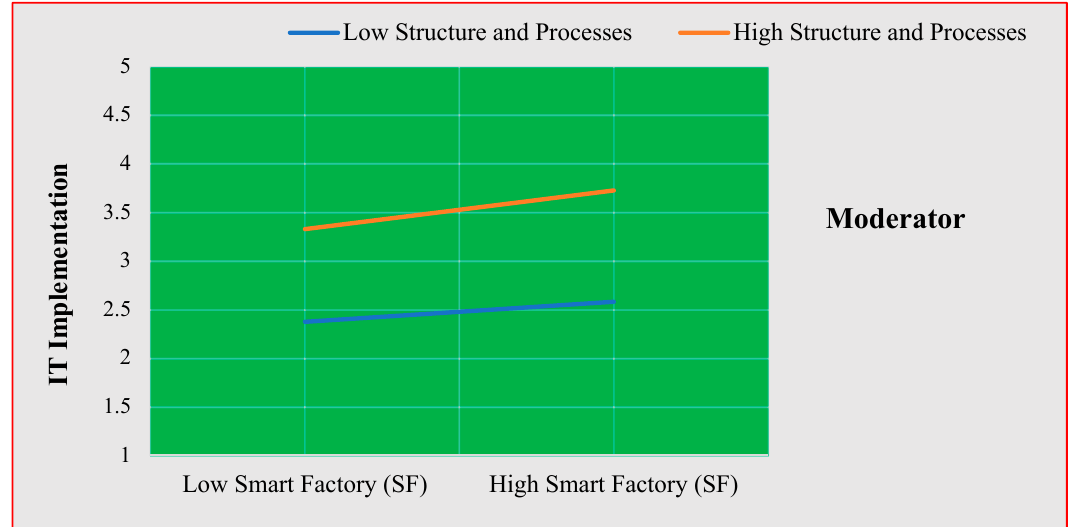
Figure 11. Moderation effect of structure and processes between smart factory (SF) and IT implementation which is strengthening the relationship.